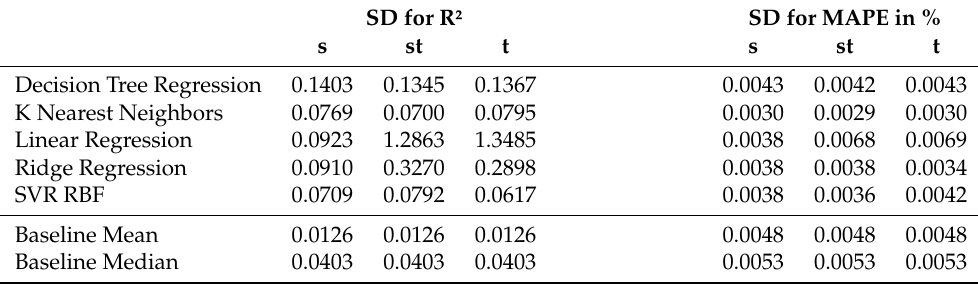
Table A2. Housing Part data set: standard deviations for the results of Target Distance A. SD for R² SD for MAPE in %